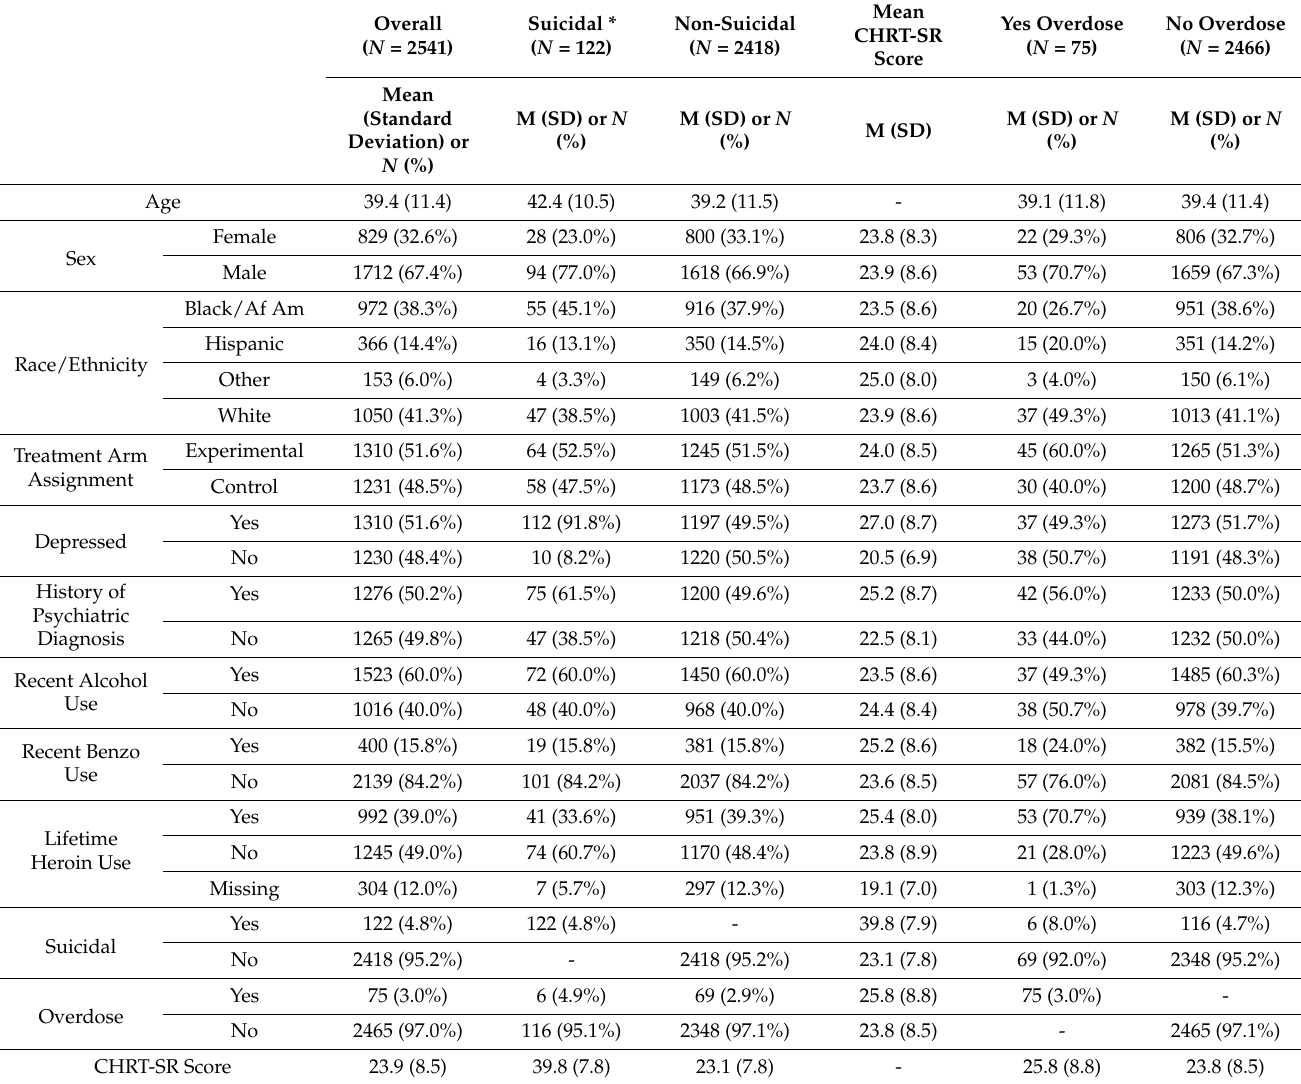
Table 2. Participant characteristics overall, by suicidal yes/no, by overdose